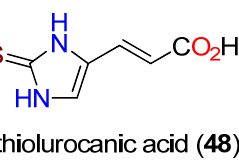
Figure 14. Structure of thiolurocanic acid ( 48 ).